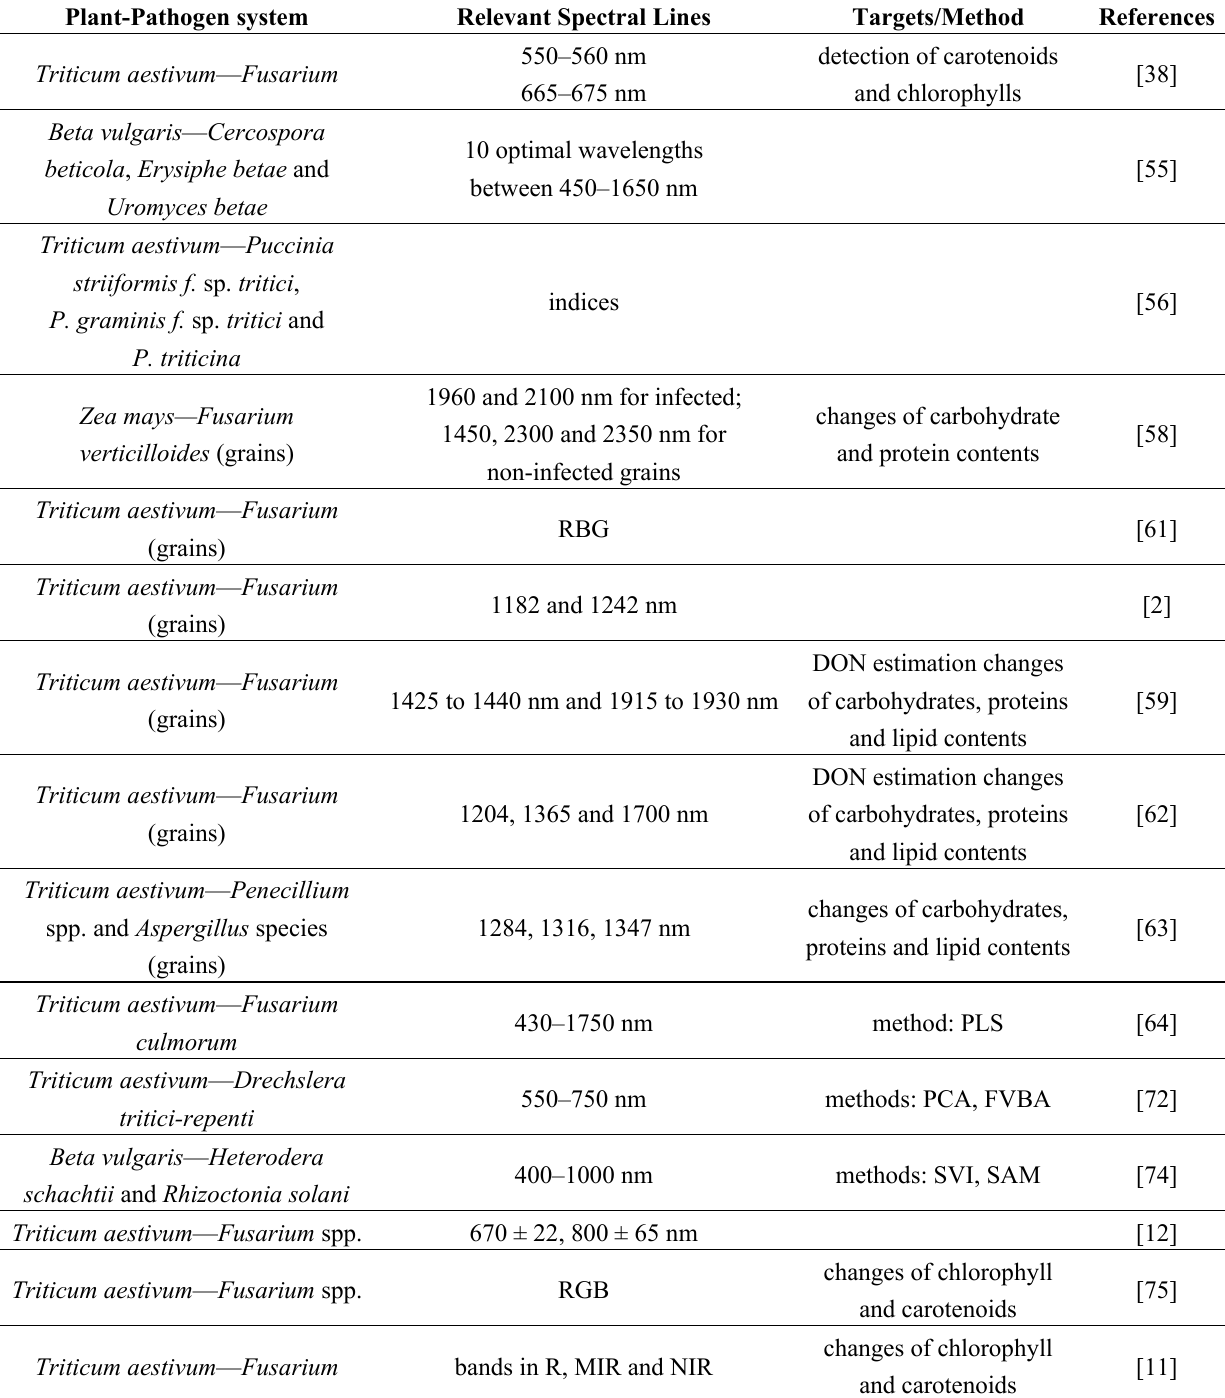
Table 1. Summary of some plant-pathogen systems, the spectral lines used for analysis and information about targets and statistical methods of